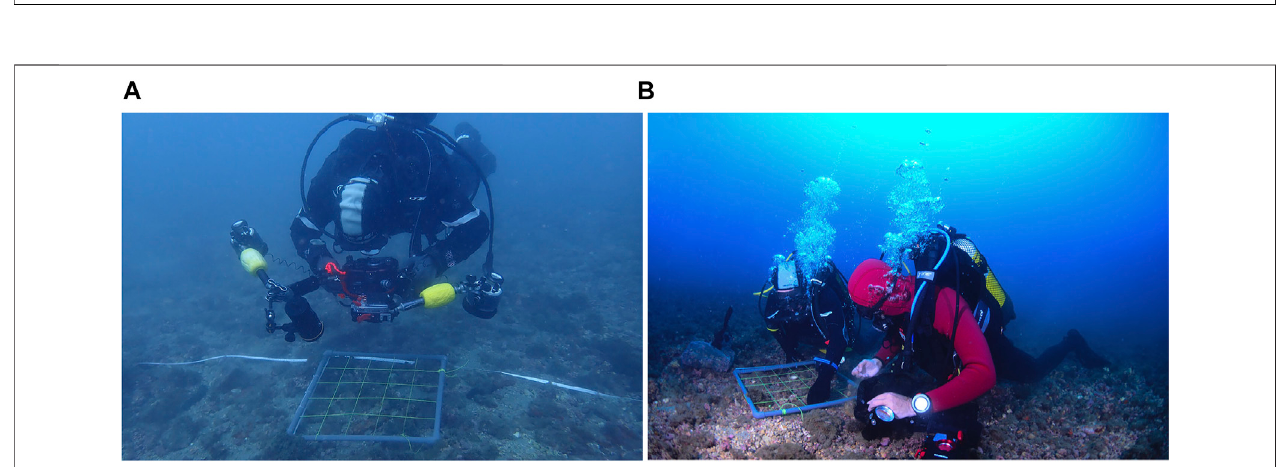
FIGURE 3 | (A) Line transect and quadrat (50 × 50-cm) for living-rhodolith cover estimation. (B) Quadrat (30 × 30-cm) for rhodolith collection.